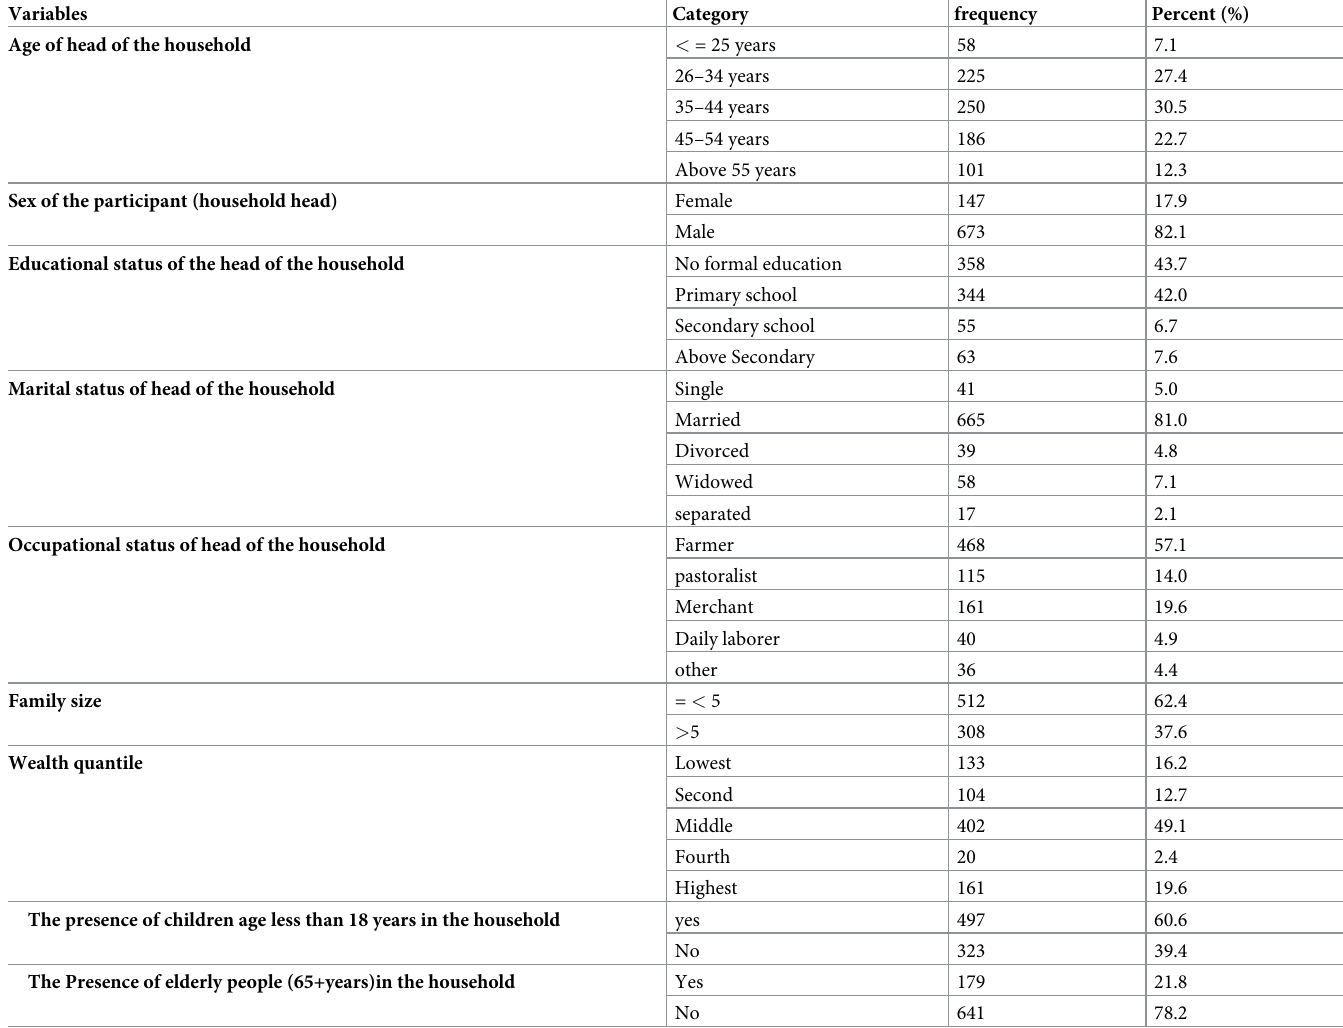
Table 1. Socio-demographic and economic characteristics of the study participants in Segen area and South Omo Zones, Southern Ethiopia, 27 April to 12 June 2018 (n = 820).